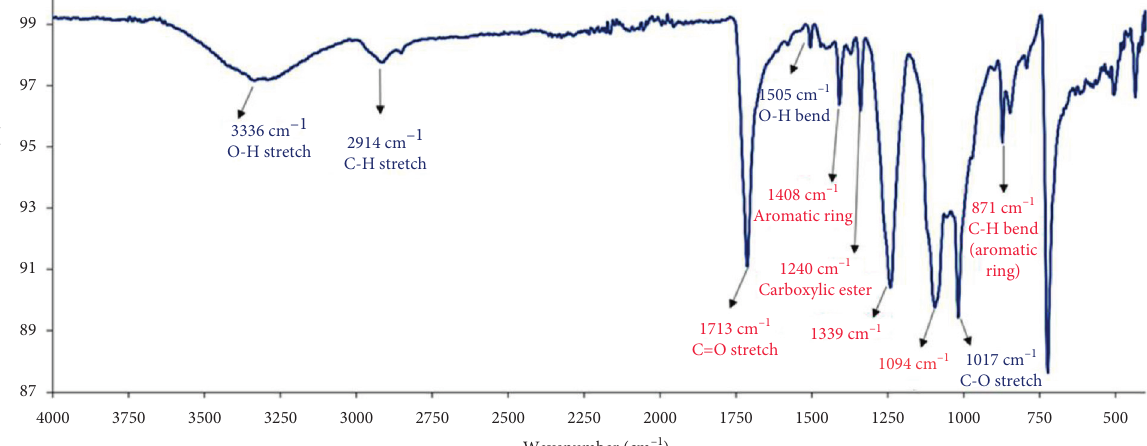
Figure 3: Absorption peaks in FT-IR spectra of the uncoated woven fabric.